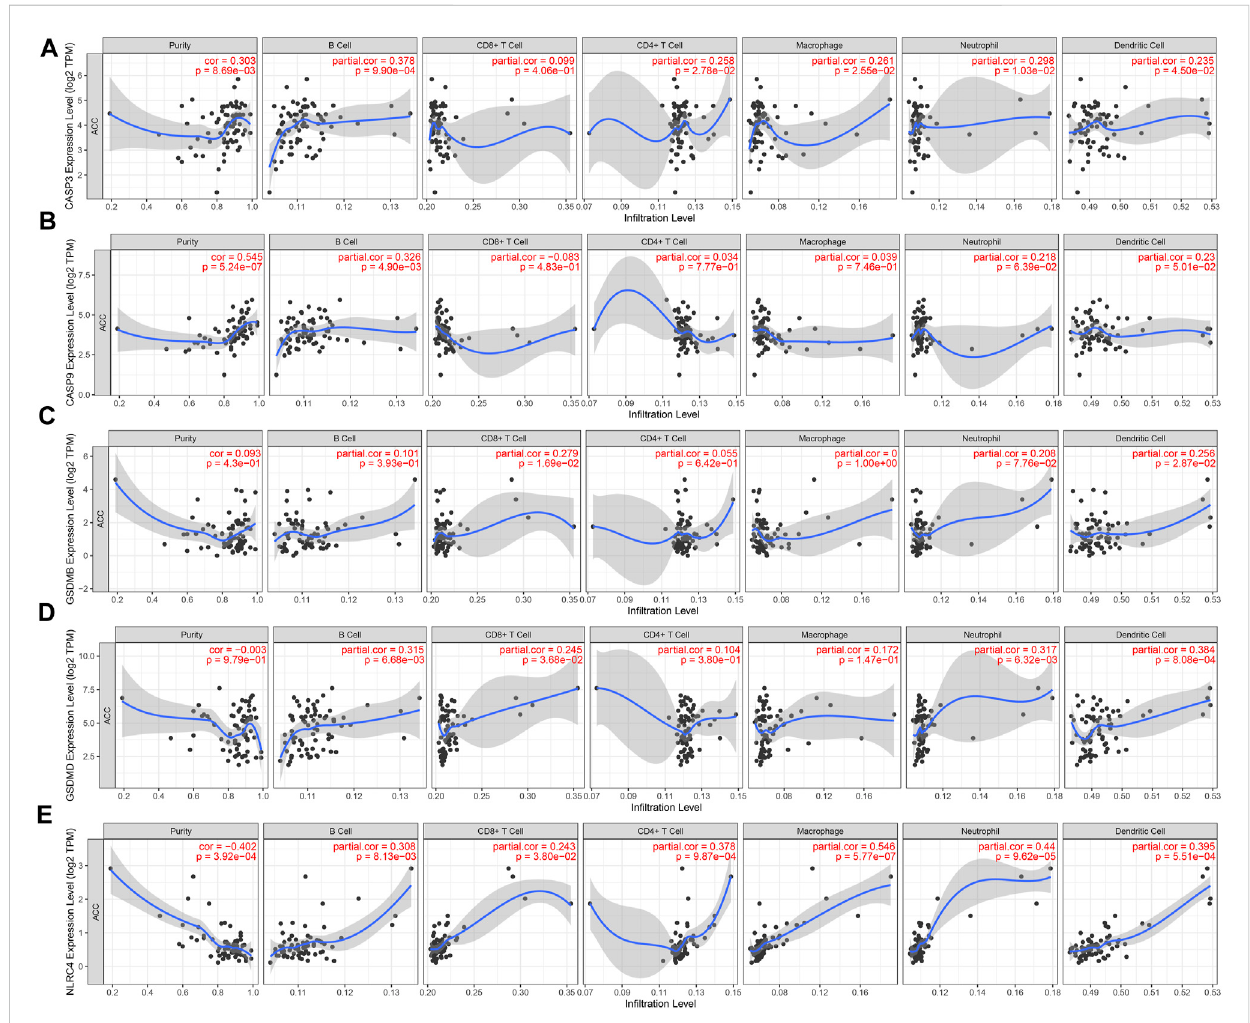
FIGURE 7 Thecorrelationbetween fi veprognosticPRGsandimmunein fi ltration.Theassociationbetweentheabundanceofimmunecellsandtheexpression of CASP3 (A) , CASP9 (B) , GSDMB (C) , GSDMD (D) , and NLRC4 (E) in